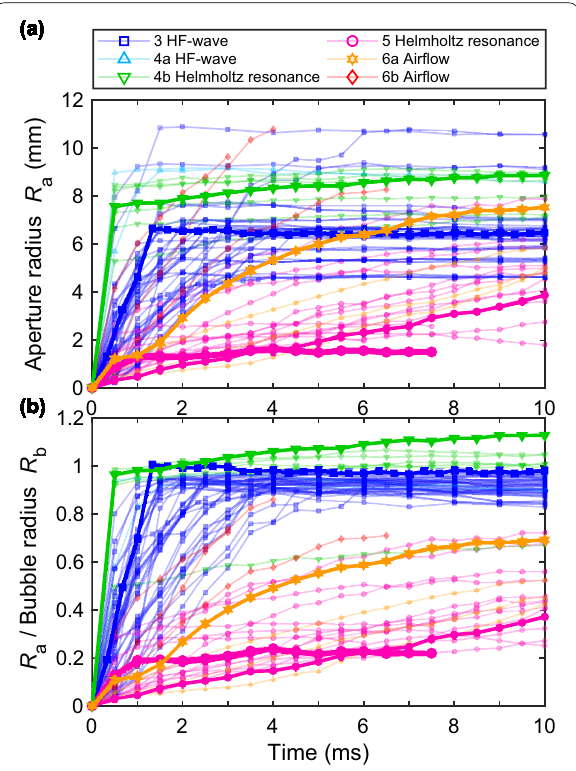
Fig. 11 Aperture radius vs. time. a R a ( t ) vs. time. Thick lines indicate the R a ( t ) of the runs shown in Figs.5, 6, 7, 8, 9 (the thickest pink line indicates the R a ( t ) for Fig. 6). Thin lines indicate runs using suspensions of φ = 0.4 , where we used all runs whose timings of aperture opening could be determined accurately. Ranges of V ( cm 3 ) are as follows ; case 3 : 0.3 - 3; case 4a : 2 - 4; case 4b : 3 - 6; case 5 : 0.6 - 7; case 6a : 10 - 12; case 6b : 10 - 12. b Normalized ( R a / R b ) version of ( a ) (see text for details)